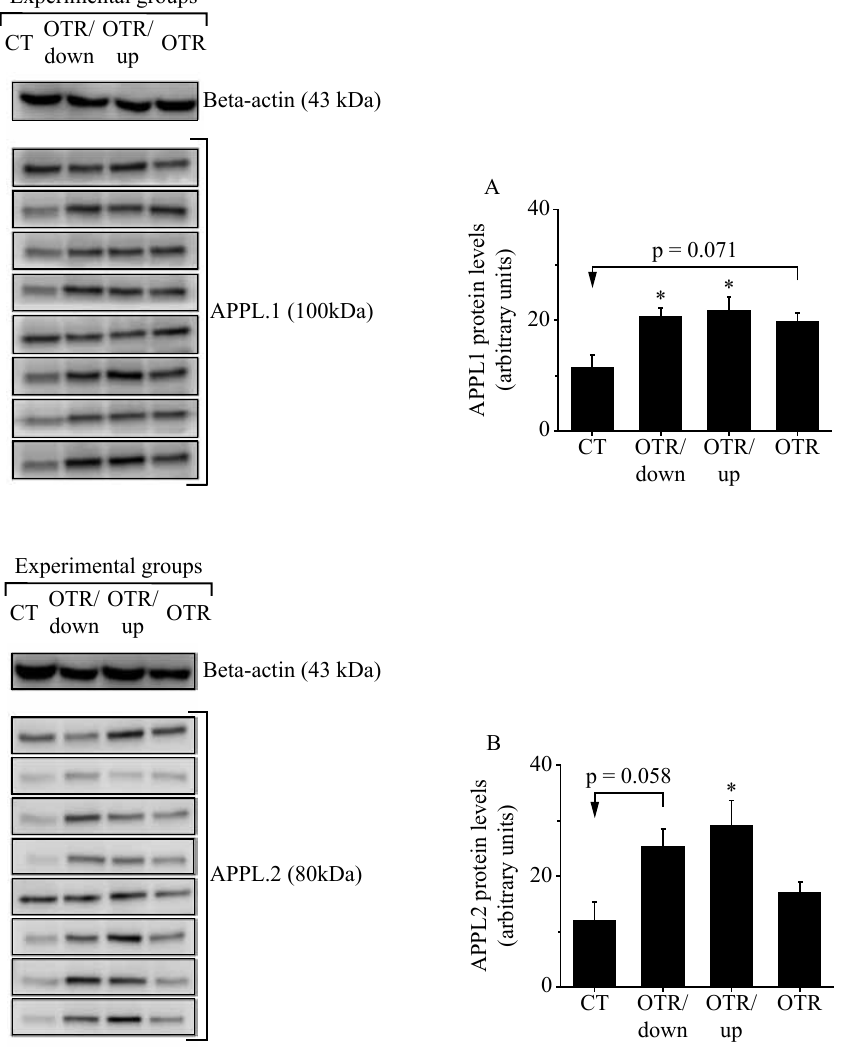
Figure 1. Protein levels (arbitrary units) of APPL1 (A) and APPL2 (B). Data correspond to the mean ± SE of 8 mice. CT: sedentary mice; OTR/ down: overtrained by downhill running; OTR/up: overtrained by uphill running; OTR: overtrained by running without inclination. *P < 0.05 vs. CT